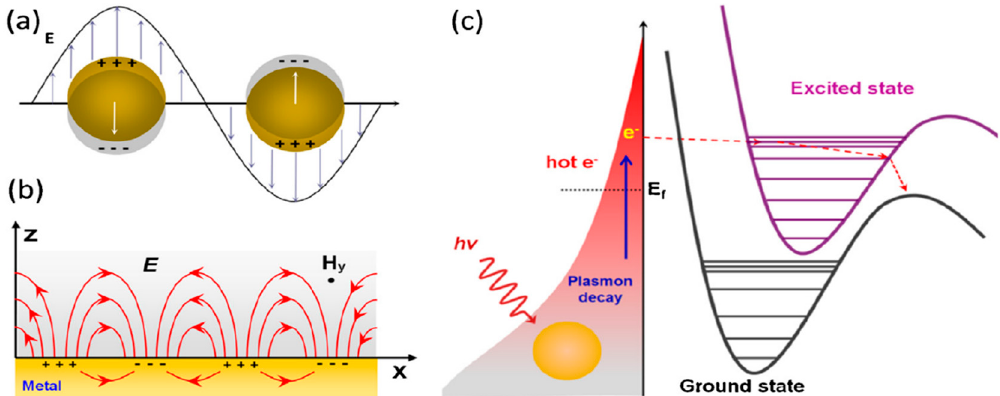
Figure 1. Sketches of the mechanism of local surface plasmons (LSPs), propagating surface plasmons (PSPs), and plasmon-driven catalytic reactions. With laser excitation on the Au or Ag nanostructures’ surface, ( a ) LSPs are density oscillations of charge confined on the metal nanoparticles’ surface; ( b ) PSPs are the electrons’ collective excitation conduction that propagates near the interface; ( c ) hot electrons generated from plasmon decay can transfer to the excited state of molecule 1, and from there initiate the catalytic reaction to molecule 2. Adapted from [3].